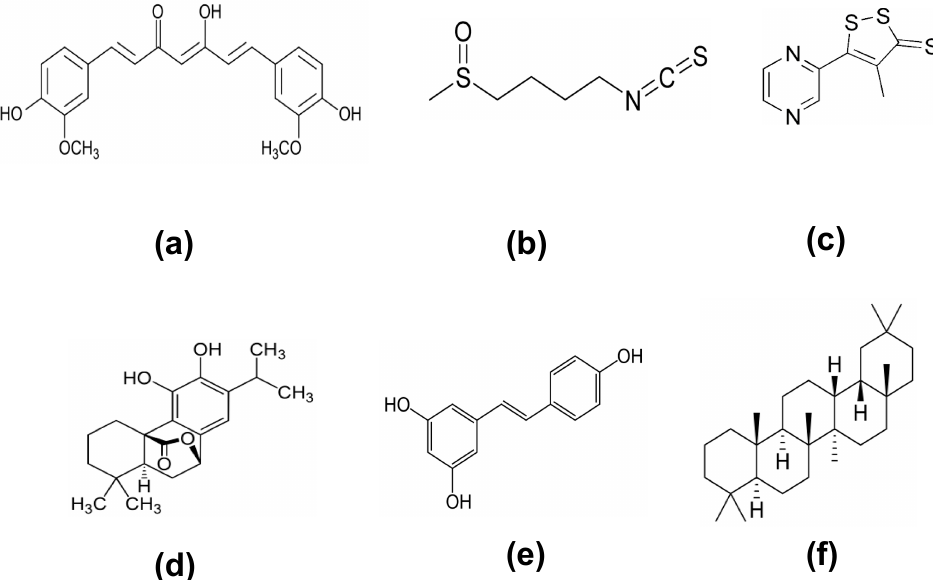
Figure 4. Some NRF2 activator molecules. ( a ) Curcumin, ( b ) sulforaphane, ( c ) oltipraz, ( d ) carnosol, ( e ) resveratrol, and ( f ) oleanane.